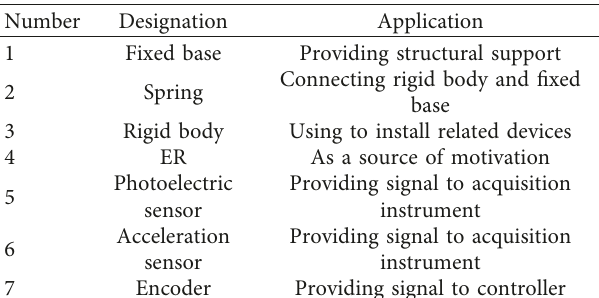
Figure 1: The vibration system driven by two ERs. (a) The dynamic model. (b) The vibration machine. (c) The experimental equipment. (d) The experimental flow. Table 1: Code